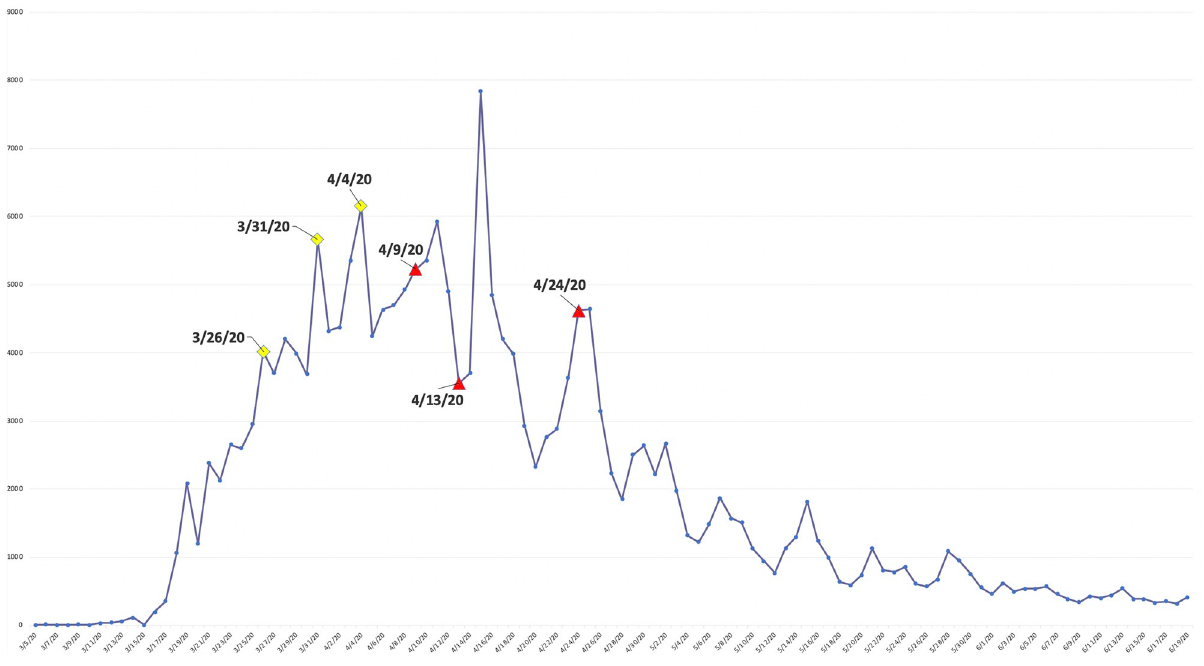
Fig 8. Daily new cases reported in New York, NY from 3/5/20 to 6/19/20.